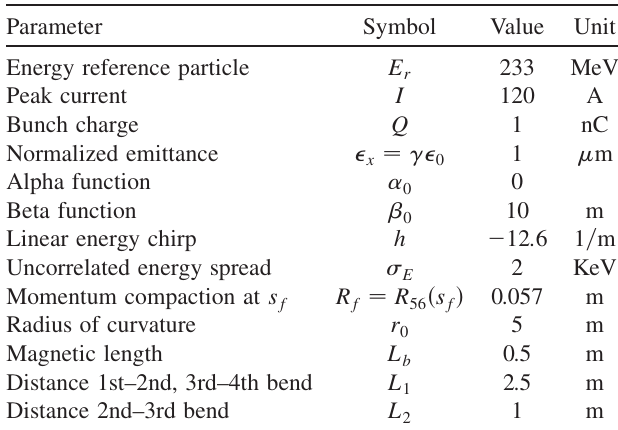
TABLE I. Chicane and beam